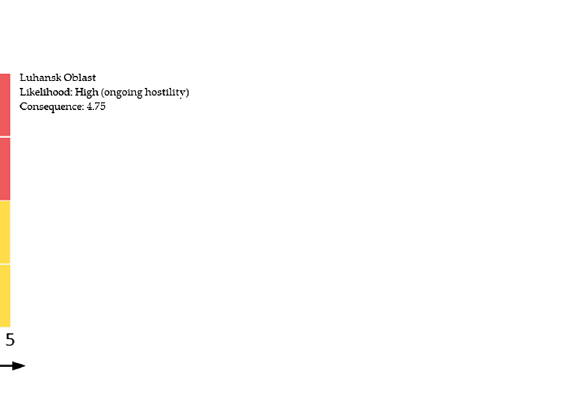
Figure 17. Disaster risk matrix for Luhansk